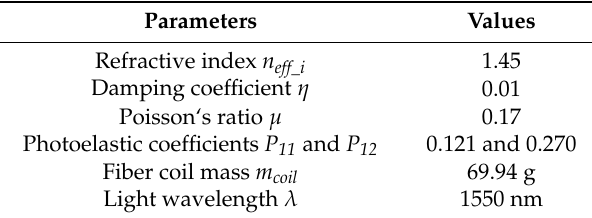
Table 2. Material